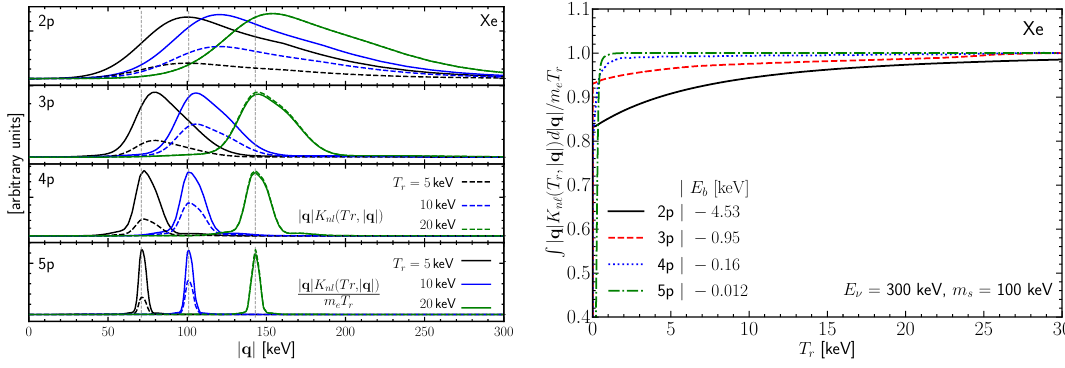
Figure 1 . The left panel shows | q | K nl ( T r , | q | ) (dashed) and the phase space ratio | q | K nl ( T r , | q | ) /m e T r (solid) for the 2 p , 3 p , 4 p and 5 p orbitals from top to bottom. Three typical recoil energies T r = 5 keV (black), 10 keV (blue), and 20 keV (green) are shown for illustration. The √ peak locations, | q | = 2 m e T r , estimated from the scattering with a free electron are shown as vertical gray lines. As a function of the electron recoil energy T r , the right panel shows the phase space ratio R | q | K nl ( T r , | q | ) d | q | /m e T r for the 2 p (black solid), 3 p (red dashed), 4 p (blue dotted) and 5 p (green dash-dotted) orbitals in the Xe atom with solar neutrino energy E ν = 300 keV and the sterile neutrino mass m s = 100